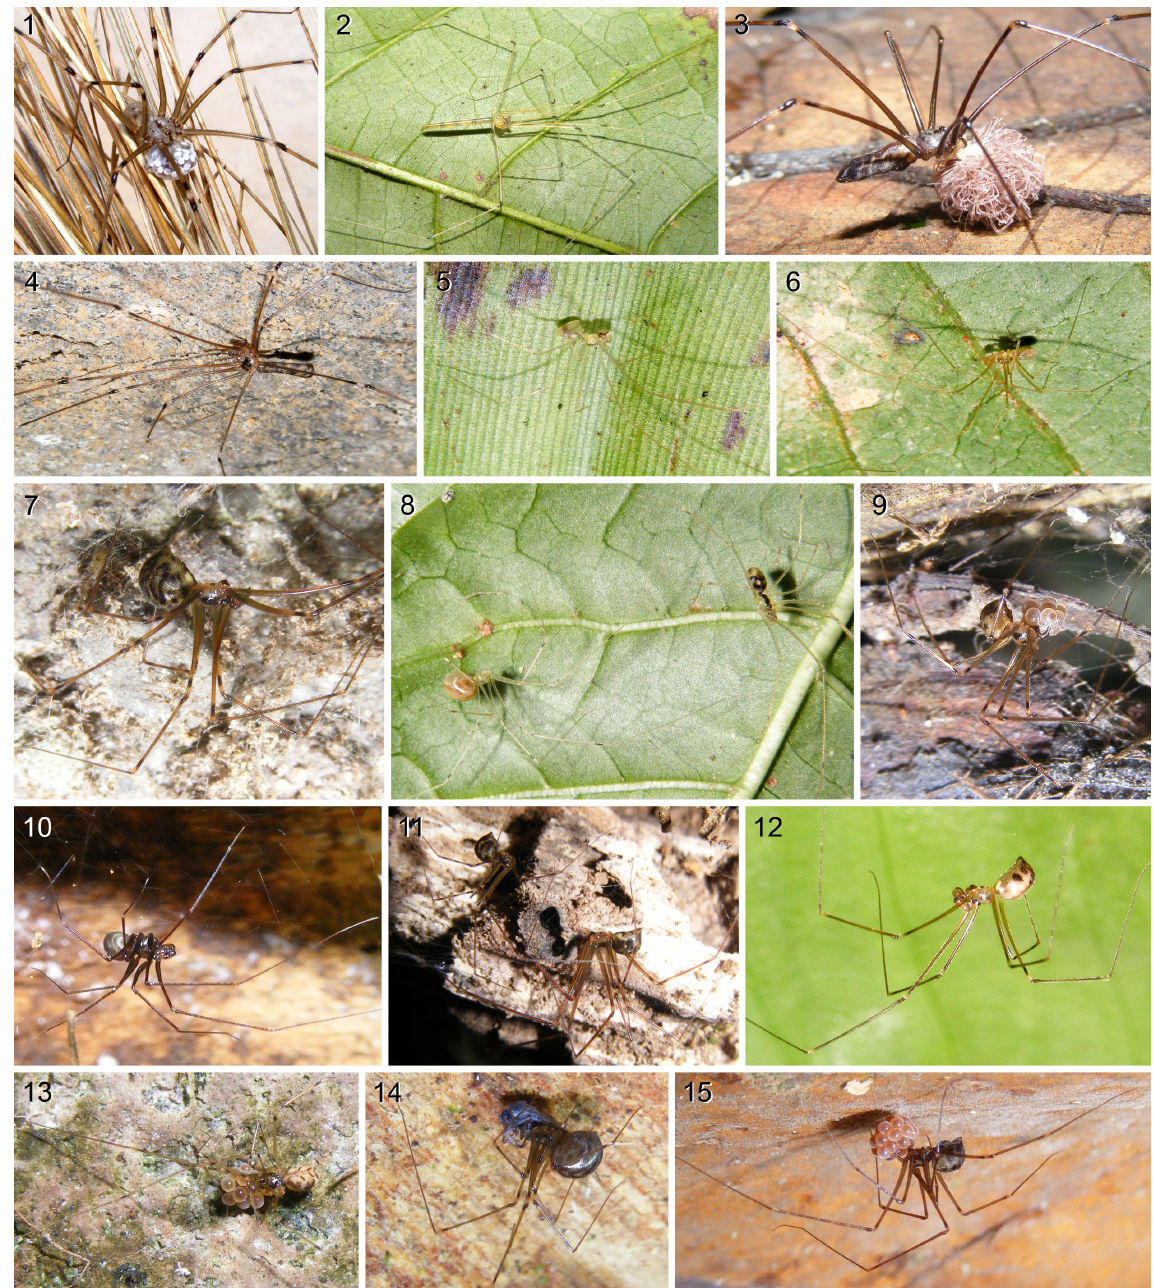
Figs 1-15. — 1 . Artema atlanta Walckenaer, 1837 from Mbutali, Kenya. — 2 . Leptopholcus tipula (Simon, 1907) from Semuliki, Uganda. — 3 . Smeringopus mpanga Huber, 2012 from Kalinzu F.r., uganda. — 4 . Pholcus taita Huber, 2011 from Taita Mountains, Kenya. — 5 . Quamtana kabale Huber, 2003 from ruwenzori, uganda. — 6 . Quamtana nyahururu sp. nov. from Thompson Falls, Kenya. — 7-8 . Spermophora minotaura Berland, 1920 from Mt. Kenya (7: dark morph; 8: light morph).